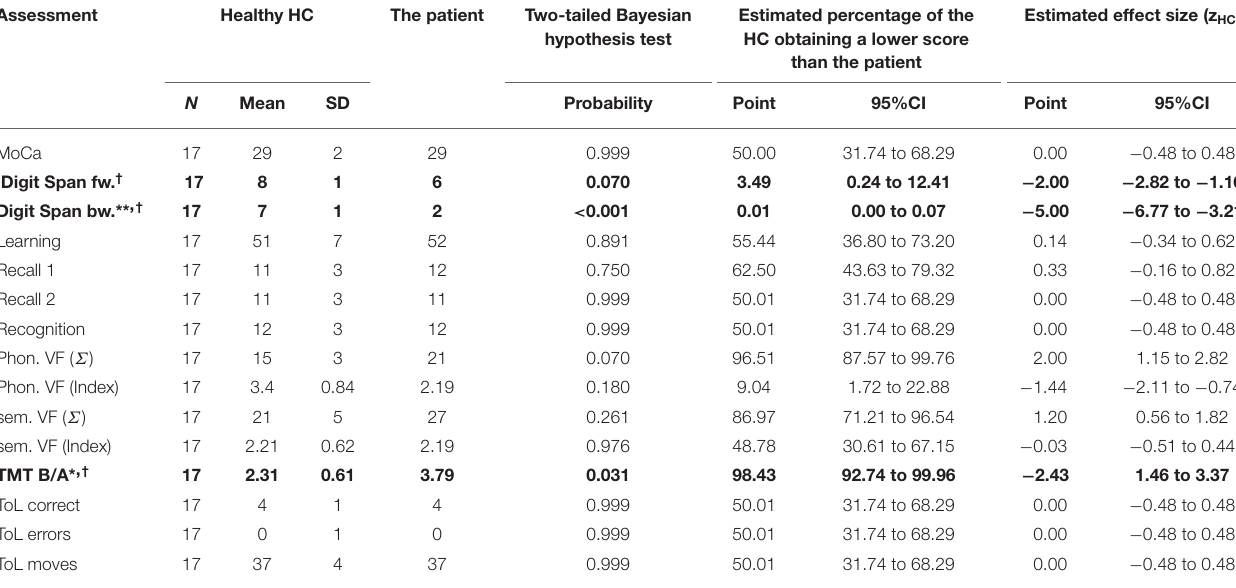
TABLE 2 | At his final follow up, the patient’s neuropsychological examination showed executive impairments. Assessment Healthy HC The patient Two-tailed Bayesian